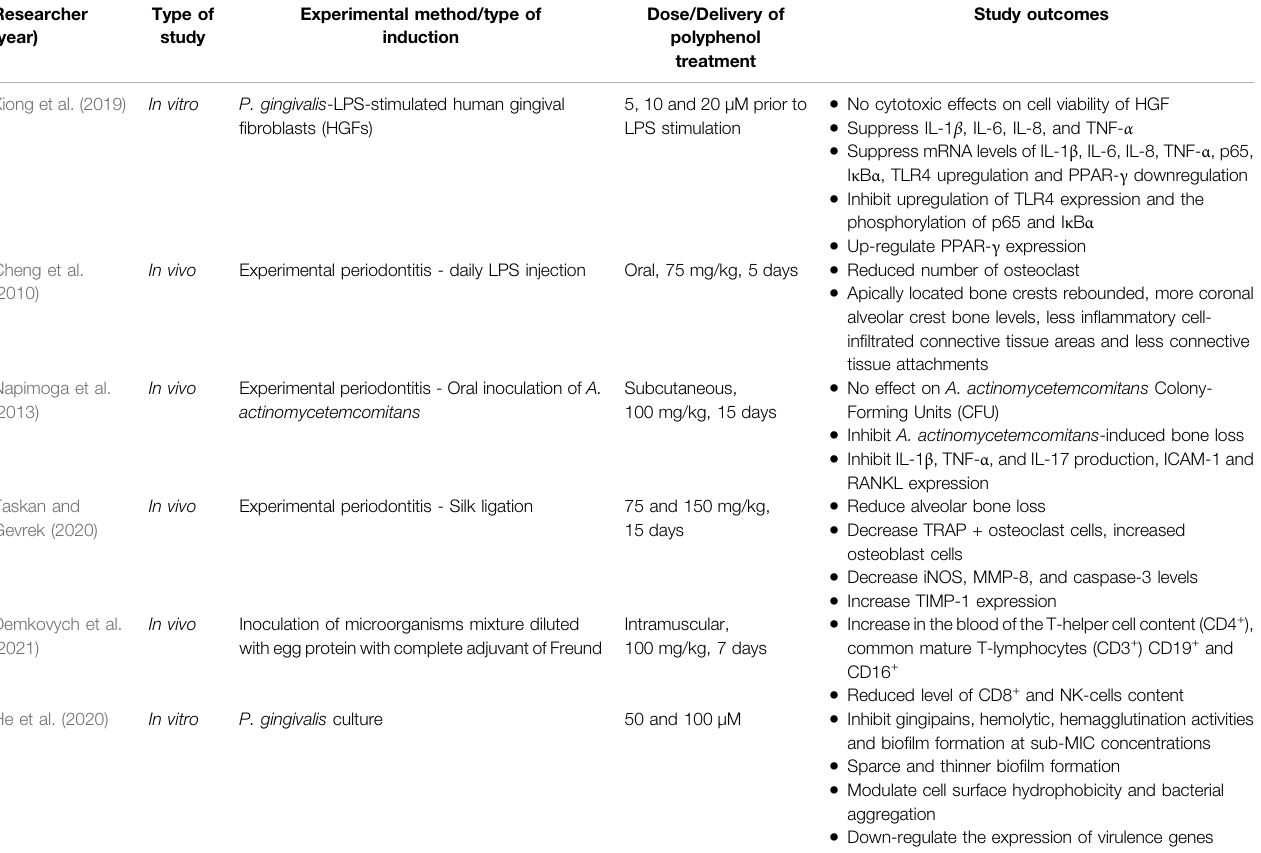
TABLE 1 | The effects of quercetin in periodontal in fl ammation, in vivo and in vitro